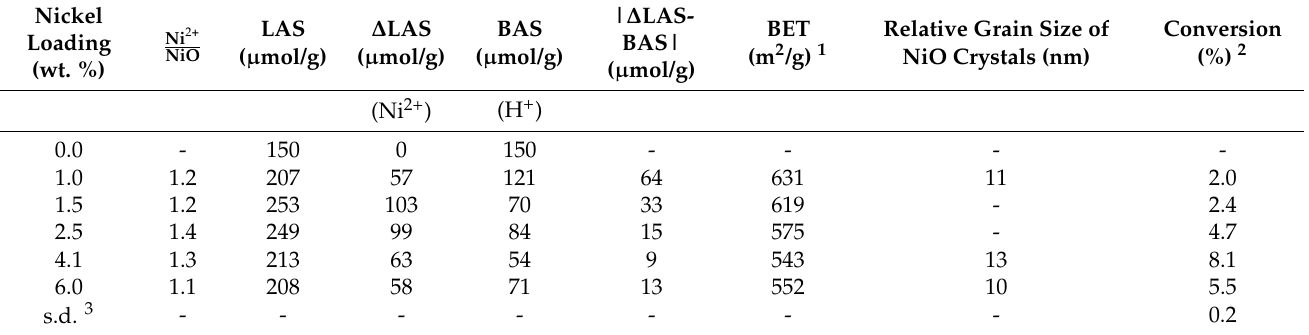
Table 3. Physicochemical properties and ethylene conversion of Ni-H-Beta catalysts as a function of nickel loading.